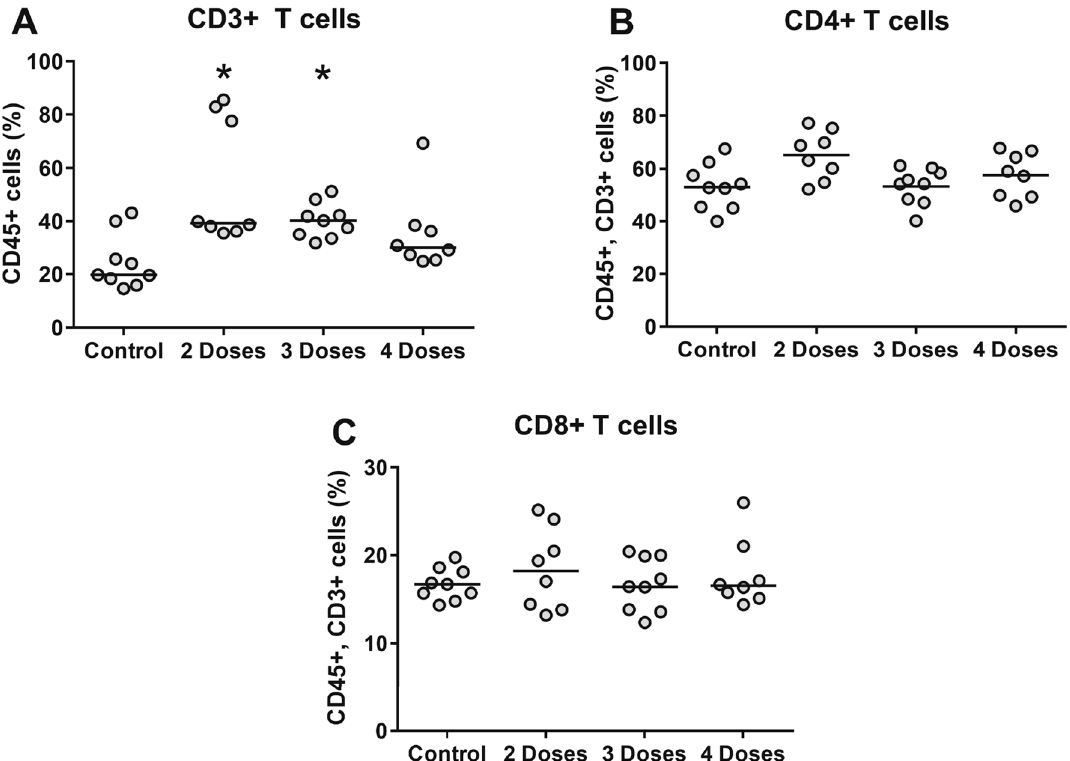
Figure 7. Impact of AGF94 treatment on tumor infiltrating T cells. Percentages of CD3+ T cells ( A ) are shown from single cell suspensions of BRLuc tumor and infiltrating lymphocytes following 2, 3 and 4 doses of AGF94 . The CD3+ population was gated off CD45+ cells. Percentage of CD4+ ( B ) and CD8+ ( C ) T cells are shown from single cell suspensions of tumor and infiltrating lymphocytes following 2, 3 and 4 doses of AGF94 . The CD4+ and CD8+ populations were gated off CD45+ and CD3+ cells. Results are shown for individual mice. Horizontal bars represent median values. Statistical comparisons were made between AGF94 -treated and control groups. * p < 0.05.